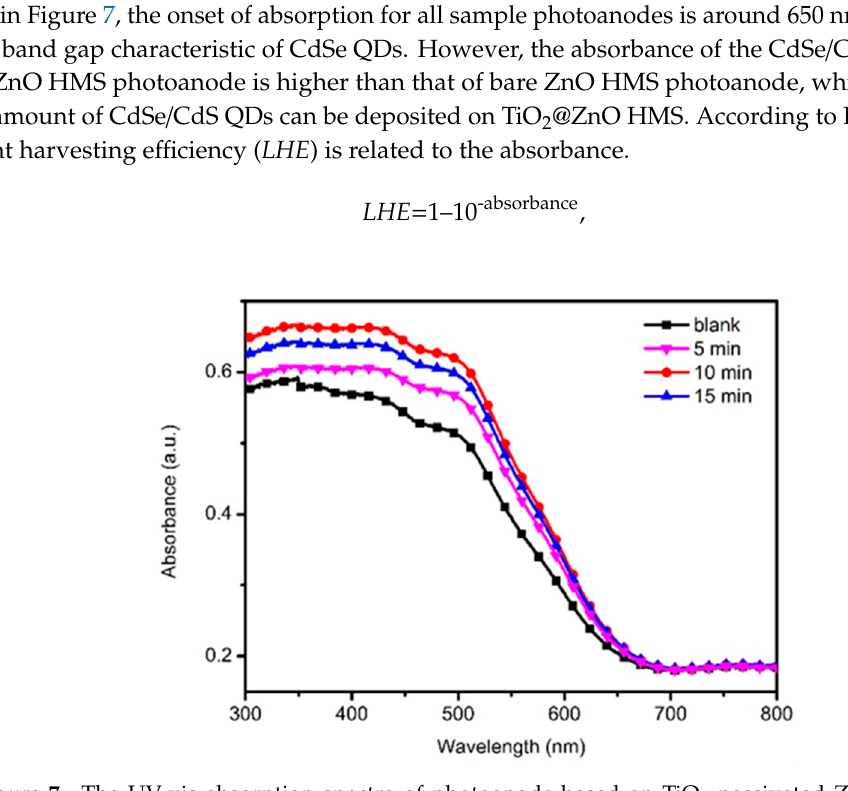
Figure 7. The UV-vis absorption spectra of photoanode based on TiO 2 -passivated ZnO HMS by immersing in in TiCl 4 aqueous solution for 0 min (blank), 5 min (5-min), 10 min (10-min) and 15 min (15-min), respectively.